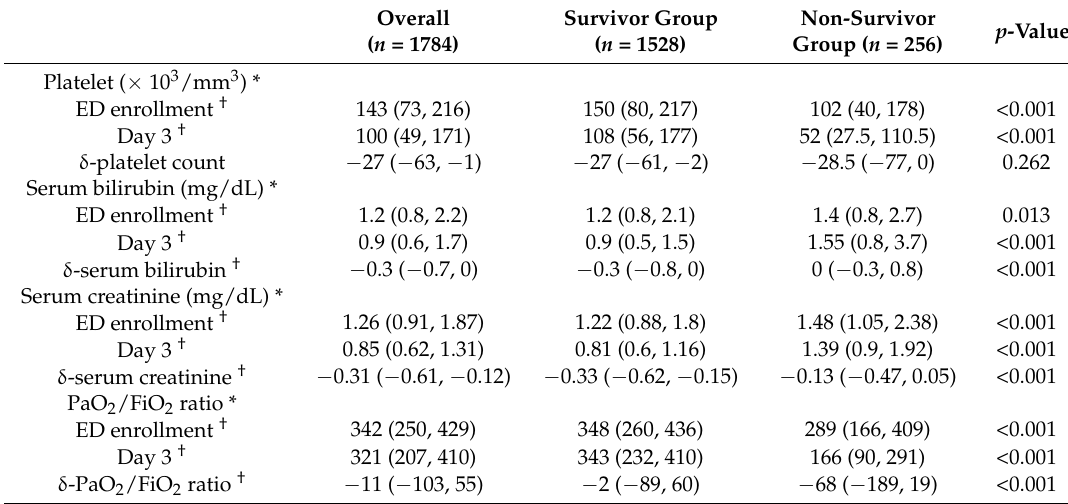
Figure 2. Kernel density plot of the time to first antibiotic therapy after triage in the emergency department. Overall, the median time to first antibiotic therapy was 2.2 h (interquartile range, 1.5, 3.3). Table 2. Comparing serum platelet, bilirubin, and creatinine levels across